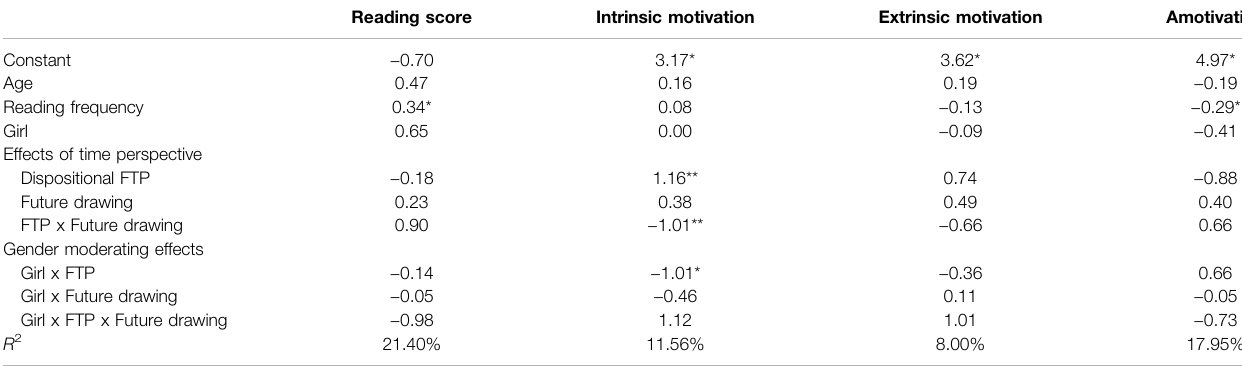
TABLE 3 | Moderating effects of gender on academic outcomes (N (cid:1)